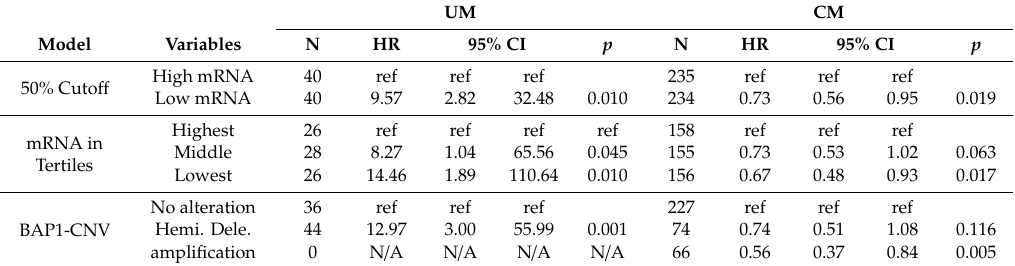
Table 1. BRCA1-Associated Protein 1 (BAP1) mRNA or copy number variation (CNV) predicted overall survival of uveal melanoma (UM) and cutaneous melanoma (CM) patients using the univariate Cox Regression model.